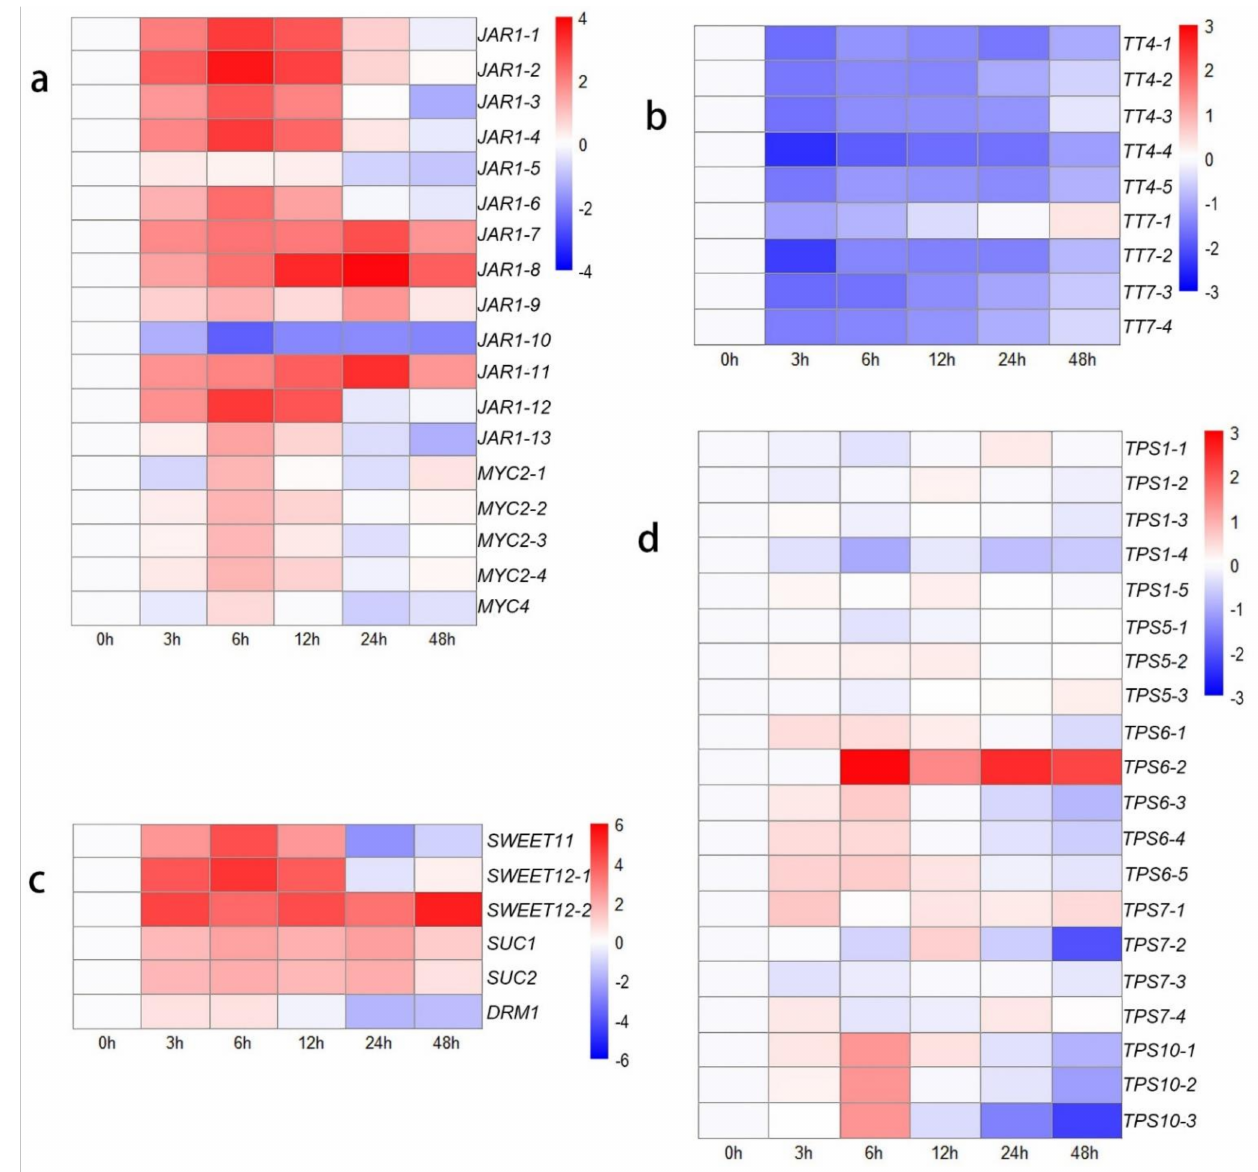
Figure 3. Heat map showing log2-normalized expression fold changes at each time point for JA-related genes and metabolism-related genes after decapitation. ( a ) JA-related genes; ( b ) flavonoid-related genes; ( c ) sucrose transport-related genes; ( d ) TPS family